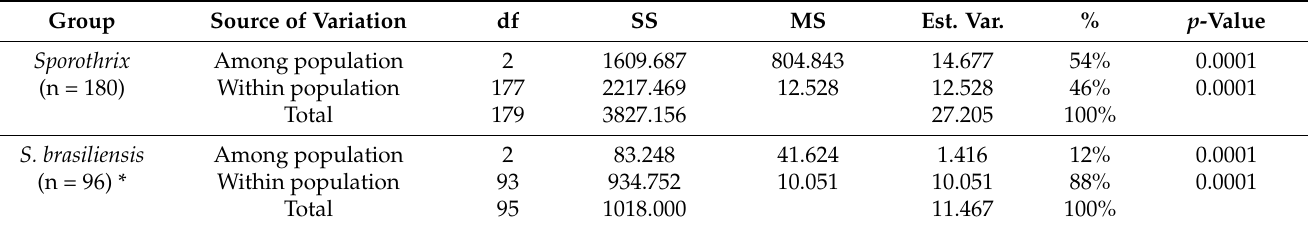
Table 4. Analysis of molecular variance (AMOVA) shows the partitioning of genetic variation within and between Sporothrix species